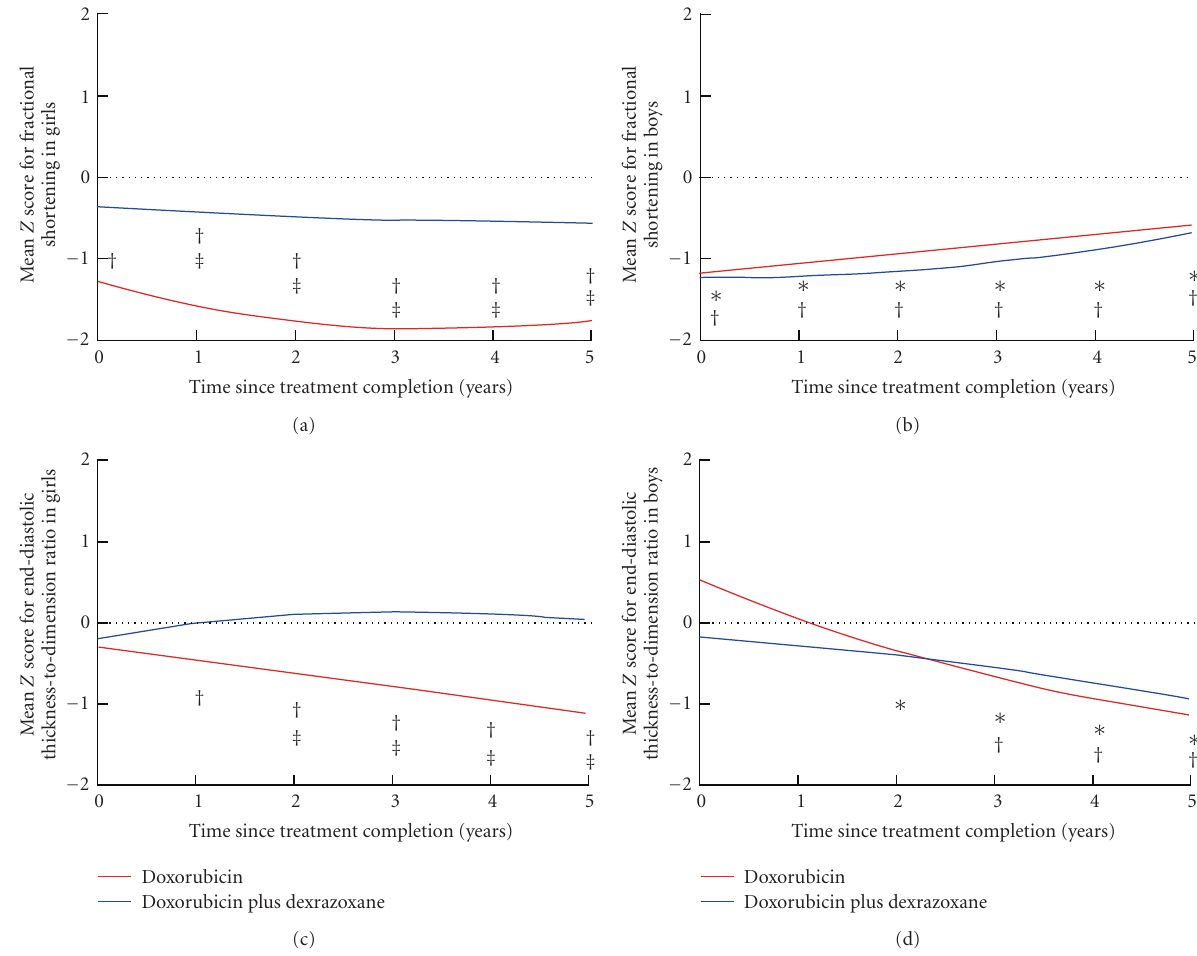
Figure 2: Mean left ventricular echocardiographic Z scores in boys and girls ( n = 134). Plots are adjusted for age; ∗ P ≤ . 05 for comparison of the mean Z score of the doxorubicin plus dexrazoxane group with zero; † P ≤ . 05 for comparison of the mean Z score for the doxorubicin group with zero; ‡ P ≤ . 05 for comparisons of mean Z scores between the doxorubicin and doxorubicin plus dexrazoxane groups. From Lipshultz et al. [53]. Reprinted with permission from